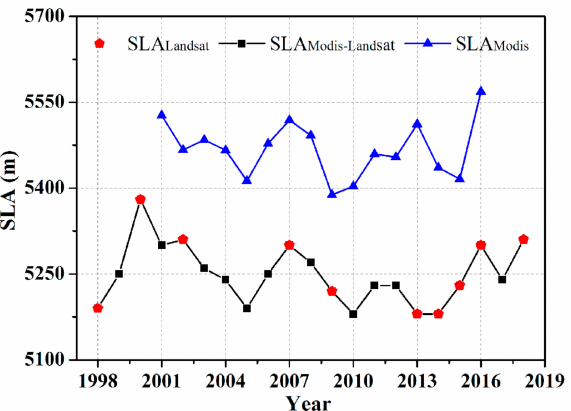
Figure 4. Landsat- and MODIS-derived SLA time series, with the Landsat-derived SLAs taken as the “true values” (example from the Western Himalayas presented). SLA Modis , SLA Landsat , and SLA Modis-Landsat represent the MODIS-derived SLA, Landsat-derived SLA, and Landsat-derived SLA with MODIS interpolation,